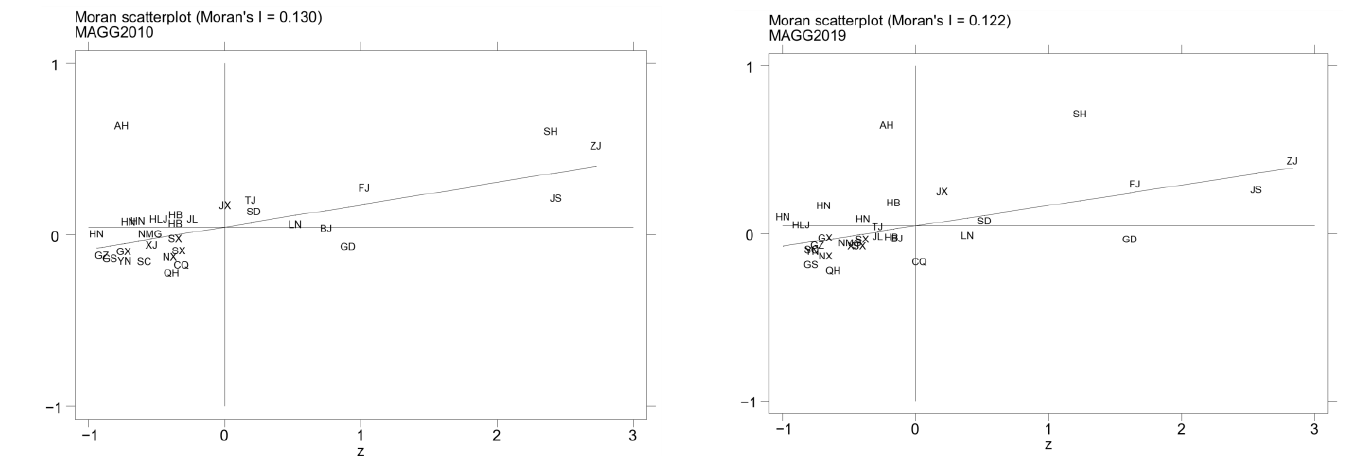
Figure 8. Local Moran’ I scatterplot of MAGG levels in China in 2010 and 2019.